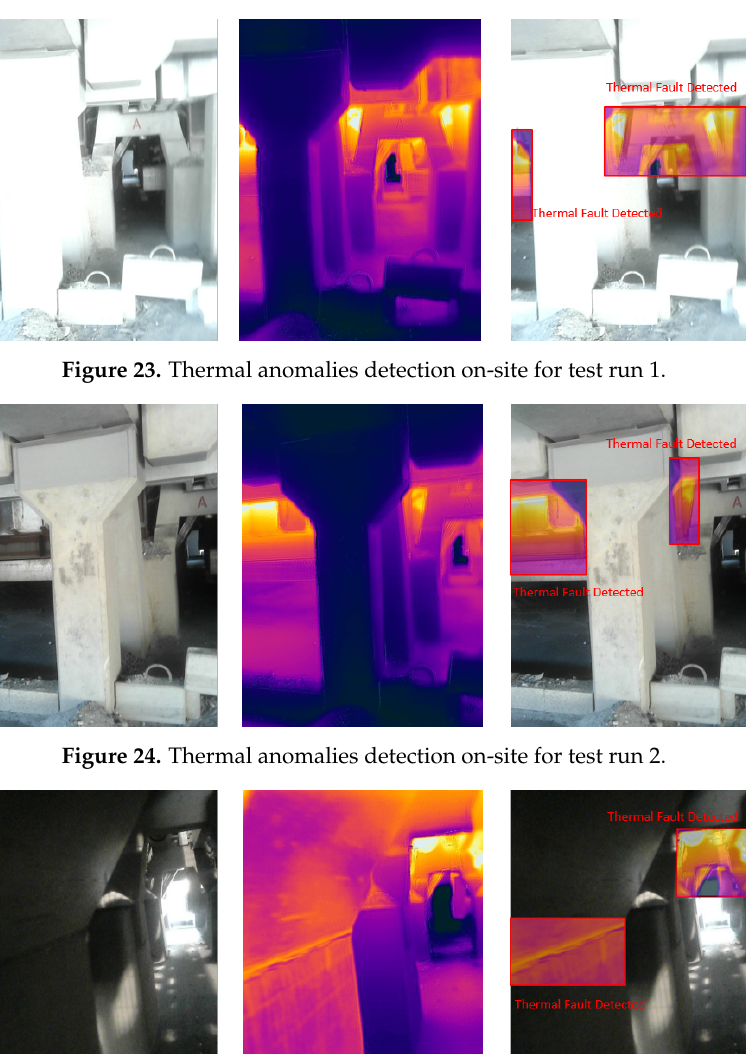
Figure 22. Thermal anomalies detection in lab environment 3.